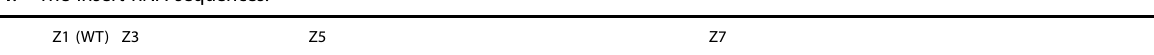
Table 1. The insert RNA sequences. Name Insert RNA